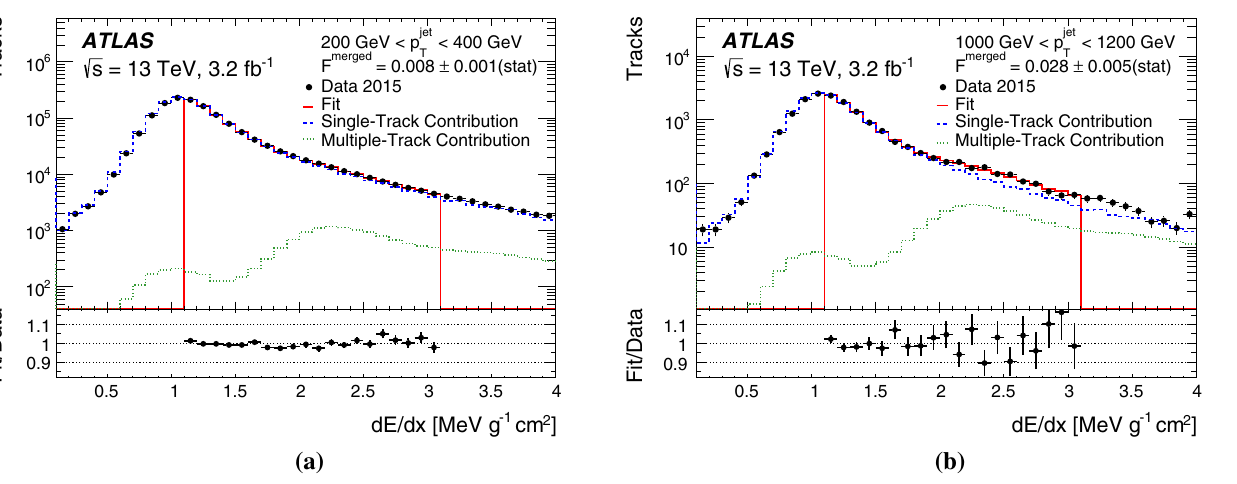
Fig. 16 Data d E / dx measurement distributions (black circles) with fit 1 − F merged is shown as the single-track contribution (dashed line) and < 400 GeV and the multiple-track template scaled by F merged is shown as the multiple- results (solid line) are shown for a 200 GeV < p jet T track contribution (dotted line). The bottom panel in each plot shows < 1200 GeV. The single-track template scaled by b 1000 GeV < p jet T the ratio of the fit to the data within the fit range (1.1–3.07 MeVg − 1 cm 2 )